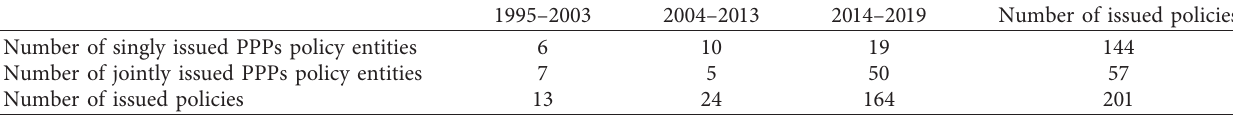
Table 2: Number of singly and jointly issued PPPs policy entities in China.